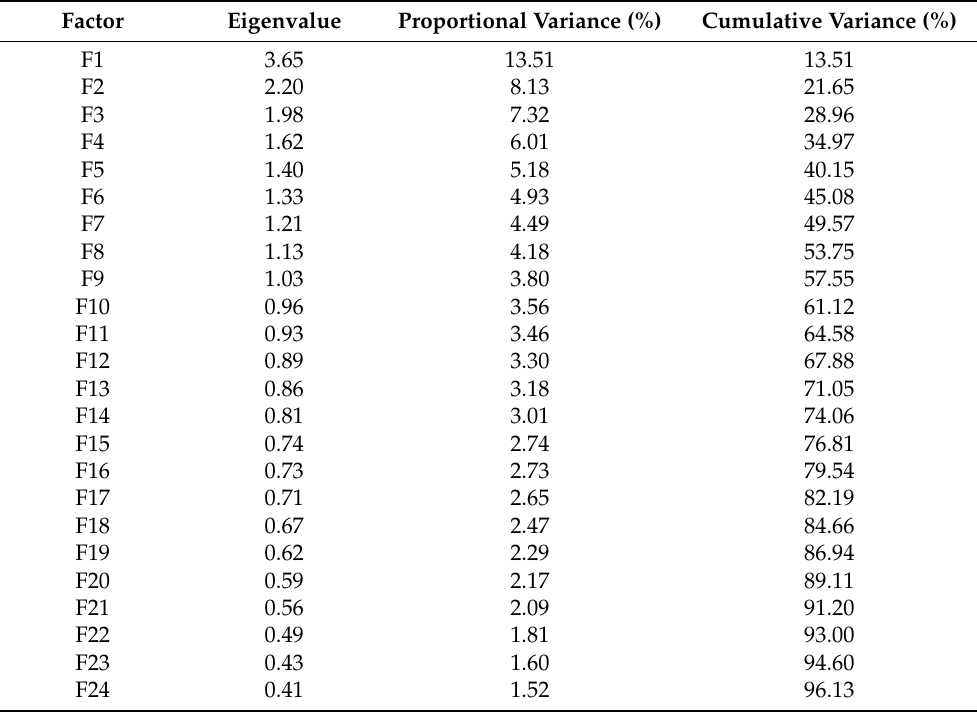
Table 3. Eigenvalues and proportion of total and cumulative variance explained by factor analysis of the body conformation traits in dual-purpose Simmental